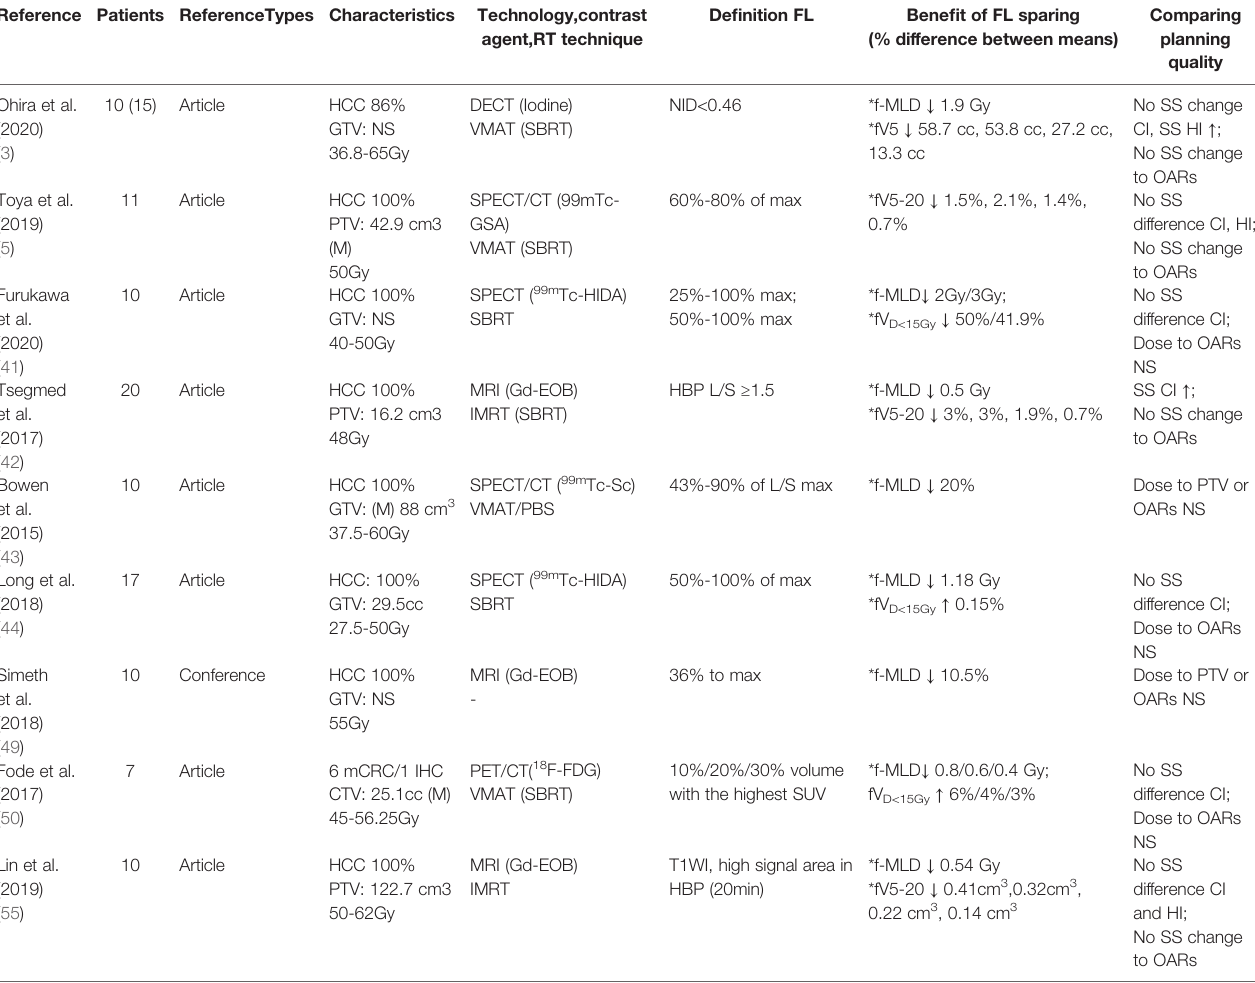
TABLE 1 | Provides detailed descriptions of each study, including patients ’ information, functional imaging/planning technique utilized, functional liver de fi nition and key fi ndings. Reference Patients ReferenceTypes Characteristics Technology,contrast agent,RT